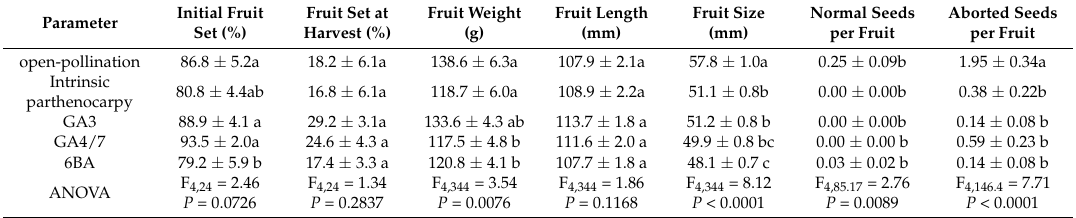
Table 4. Effect of extrinsic parthenocarpy on fruit set and fruit parameters in ‘Conference’ pear.